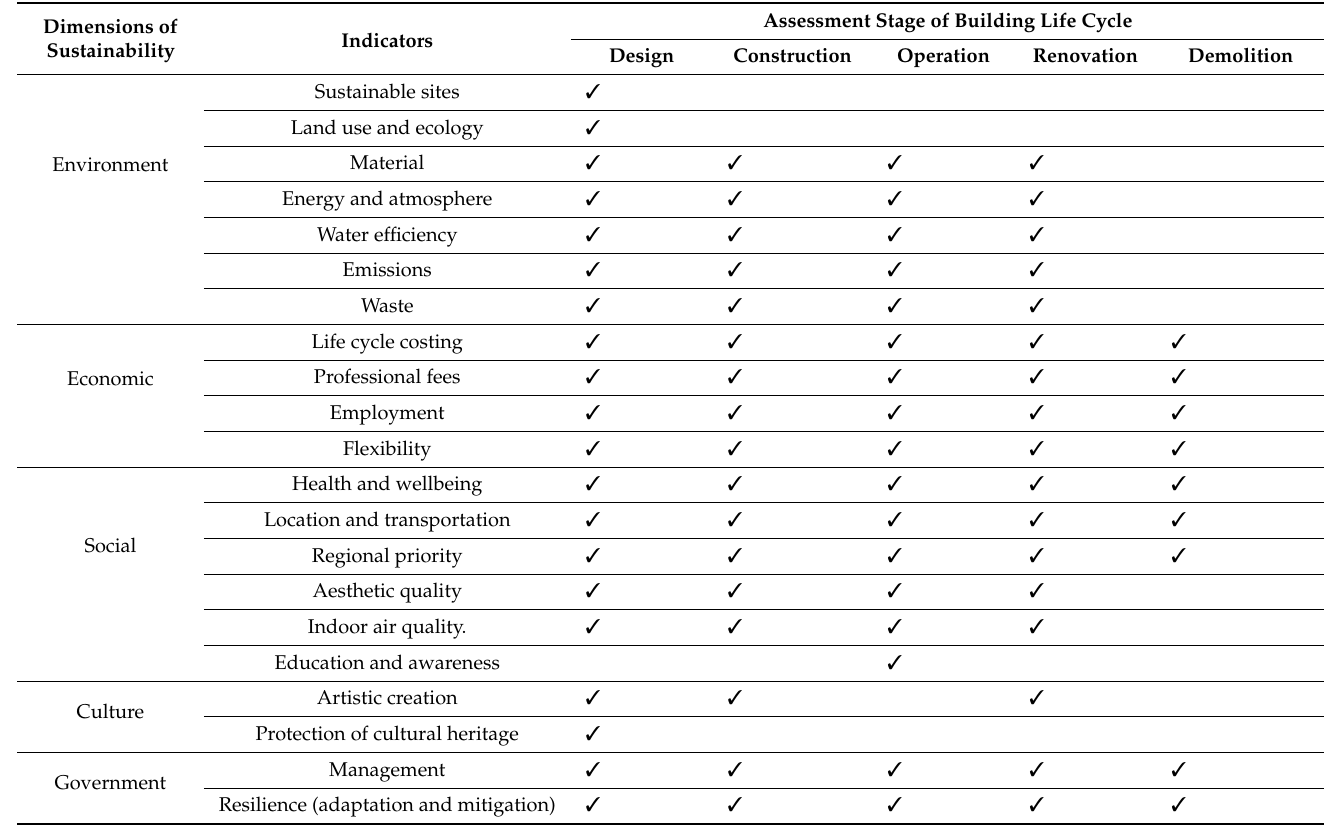
Table 5. Proposed conceptual